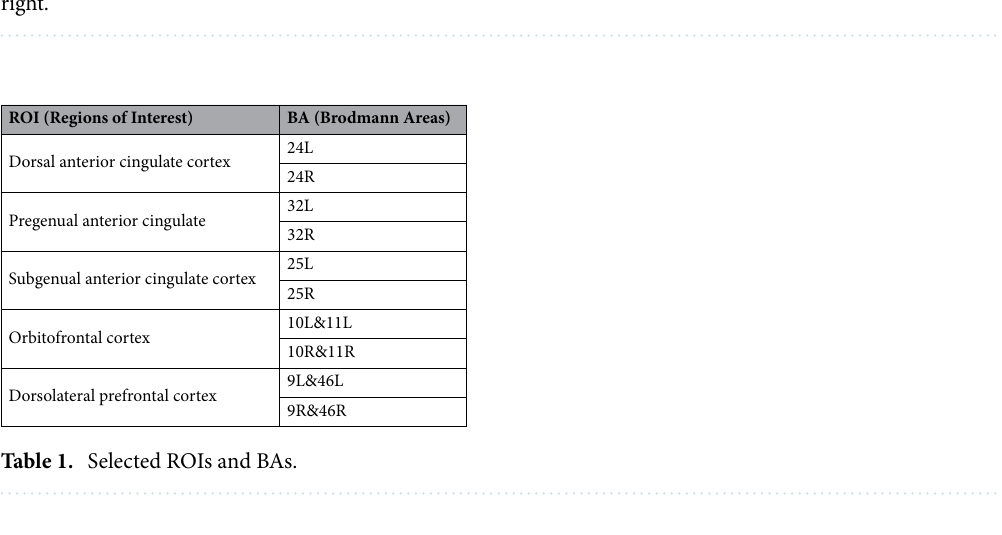
Figure 4. Examples of virtual reality tinnitus treatment scenes. Starting from left to right, the scenes were arranged based on increasing environmental noise. The participants experienced the scenes in order from left to right.